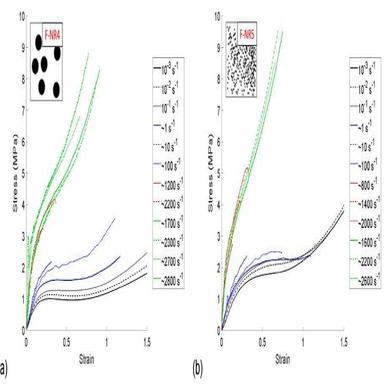
Varying strain rate data at 25 ◦C for the 50% filled composites: (a) F-NR4 and (b) F-NR5.